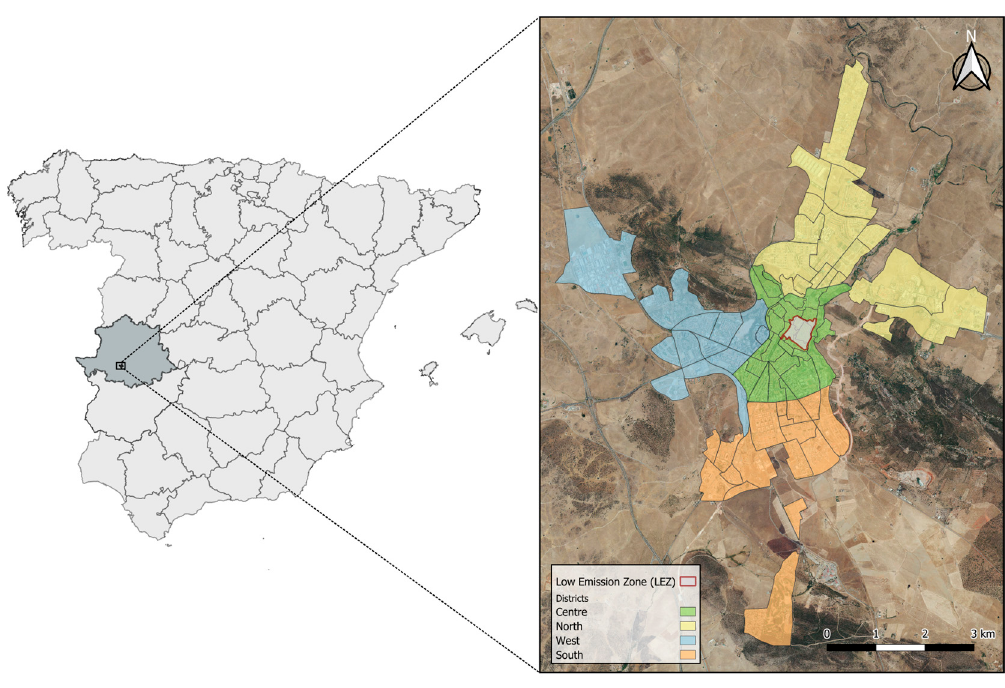
Figure 1. Location of study